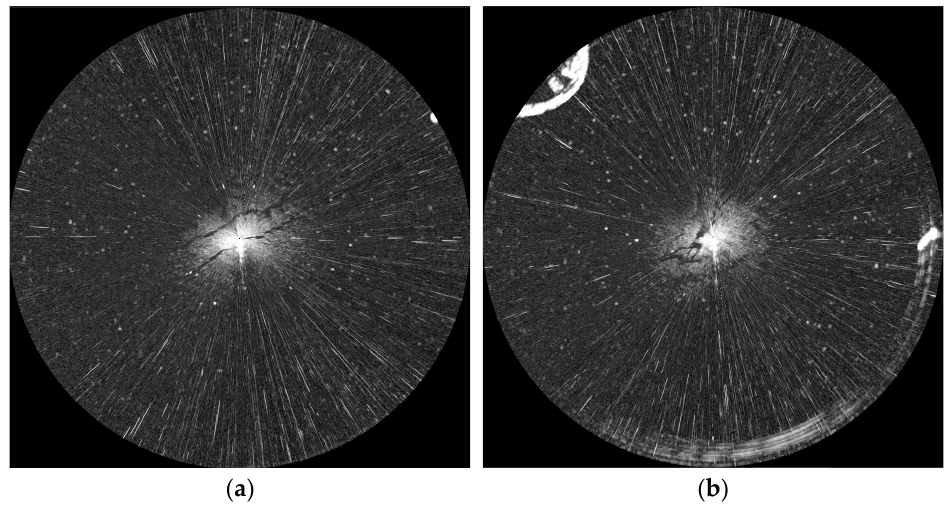
Figure 1. Marine radar remote sensing images of the Chinese Dalian 7.16 oil spill accident taken on 21 July 2010 at: ( a ) 23:19:34; ( b ) 23:21:24. Table 1. The parameters of marine radar device.